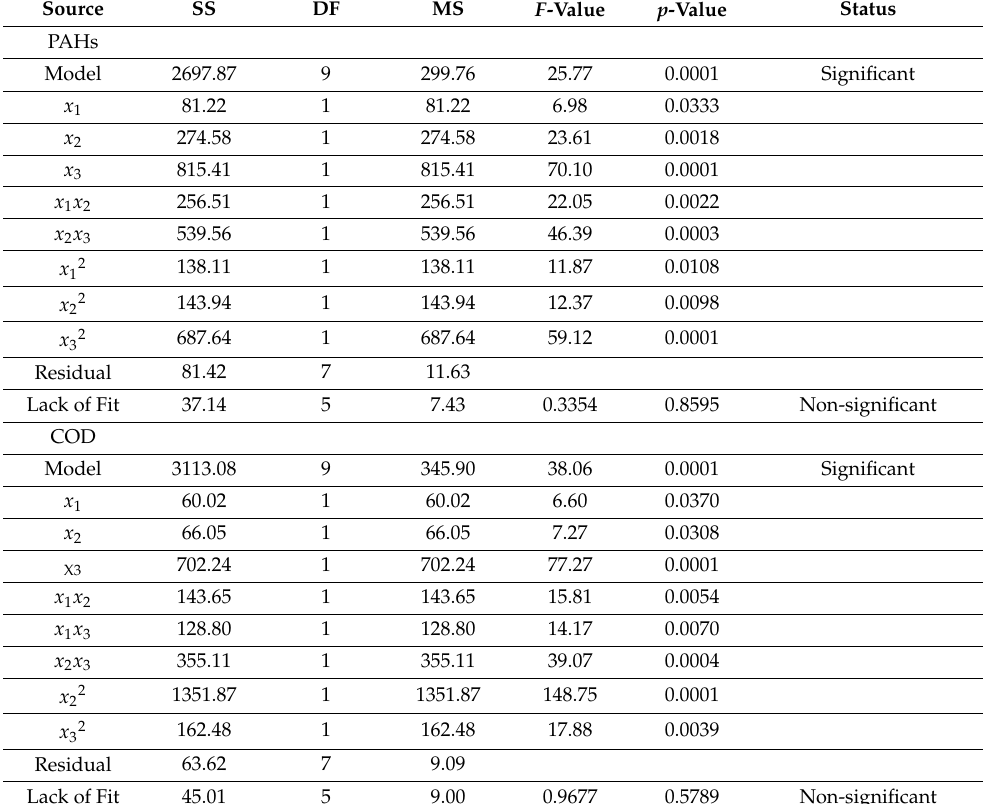
Table 3. RSM/ANOVA output table for PAHs and COD.